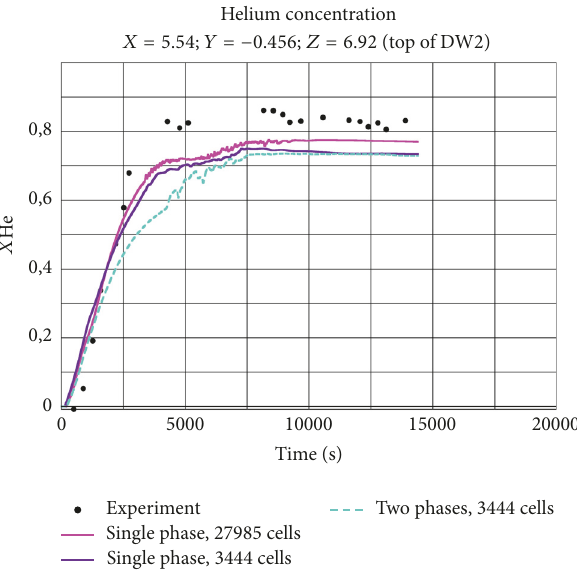
Figure 15: Helium concentration at the top of